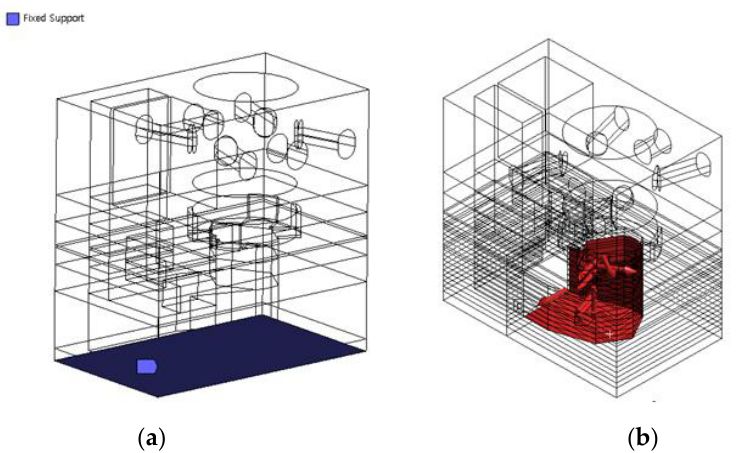
Figure 6. ( a ) Boundary conditions for structural analysis. ( b ) Load conditions for structural analysis.